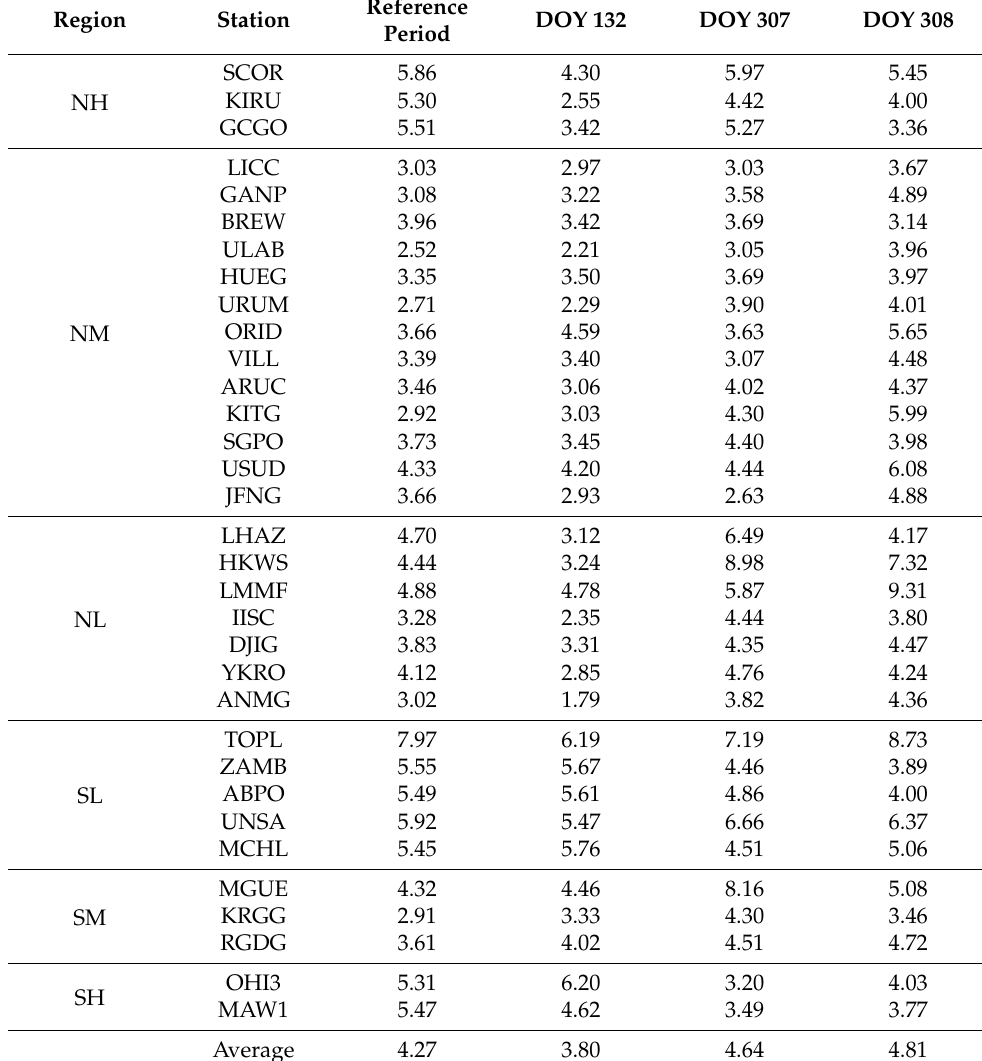
Table 5. 3D positioning accuracy during reference periods and strong geomagnetic storms for BDS + BDSK8 (unit: m). N stands for Northern Hemisphere, S for Southern Hemisphere, H for